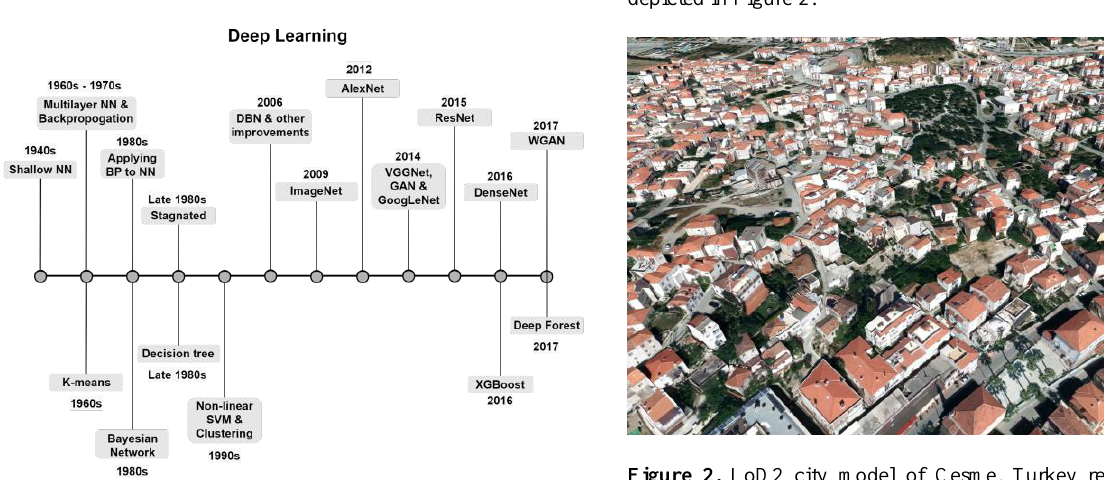
Figure 2. LoD2 city model of Cesme, Turkey